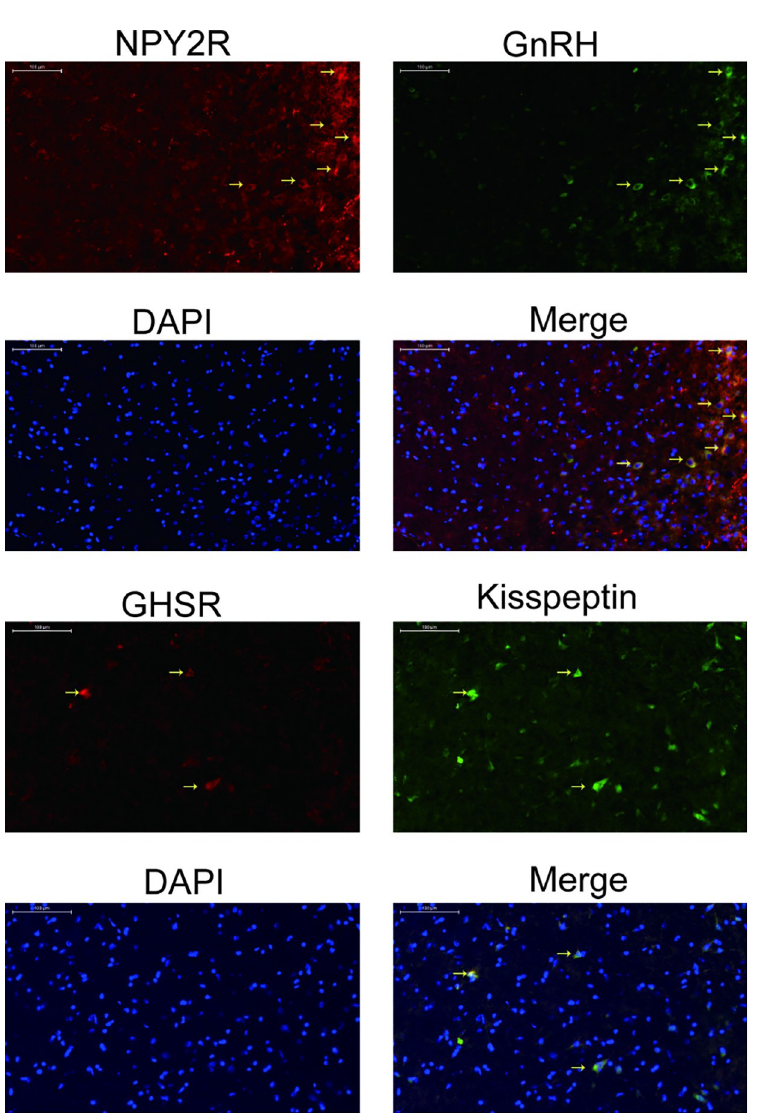
Y2 receptor; ARC, arcuate